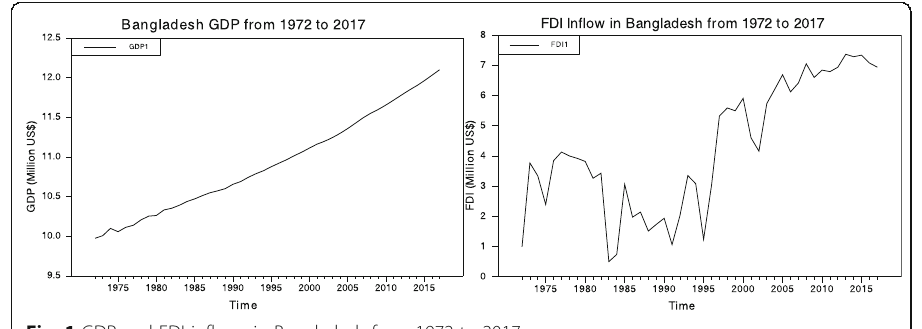
Fig. 1 GDP and FDI inflows in Bangladesh from 1972 to